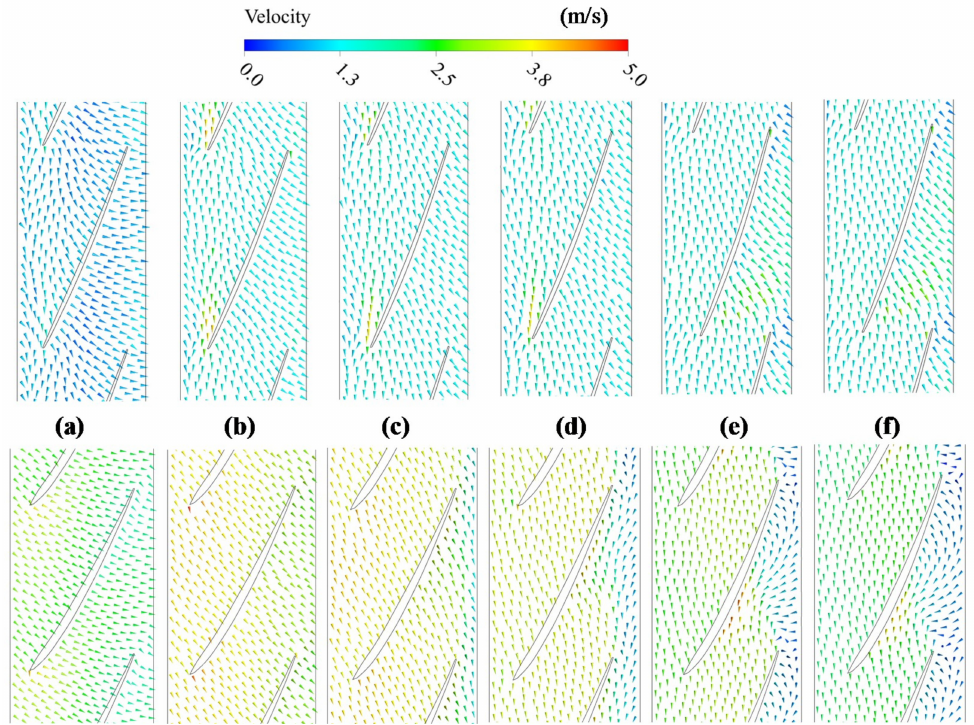
Figure 13. Velocity vector distribution on Span 1 ( upper ) and Span 2 ( lower ) at different time: ( a ) t = 0 s, ( b ) t = 1.76 s, ( c ) t = 3.2 s, ( d ) t = 4.8 s, ( e ) t = 6.4 s, and ( f ) t = 7.0